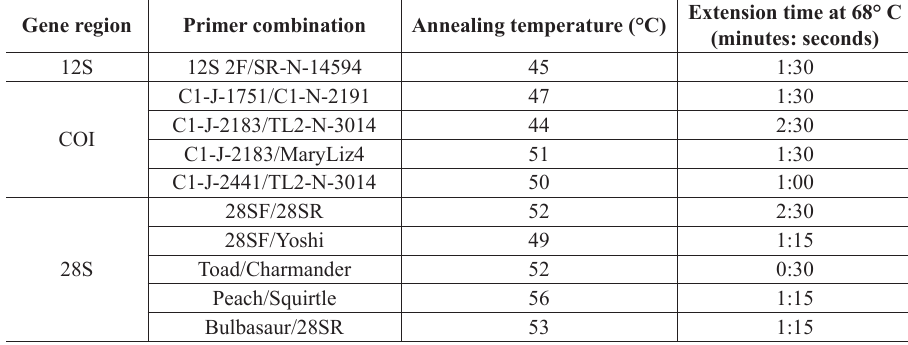
Table 2. Annealing temperatures and extension times used in this study. Gene region Primer